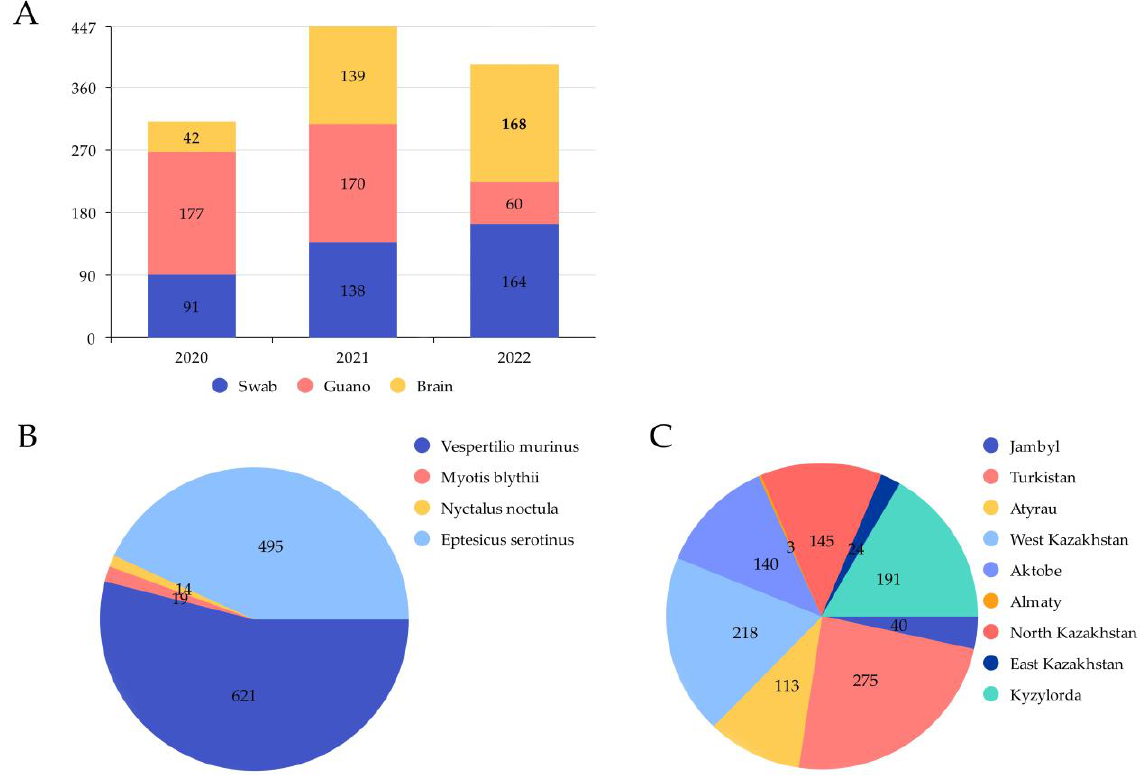
Figure 2. Characterization of the collected samples. ( A ) Graph showing the distribution of the number of samples taken from 2020 to 2022. ( B ) Number of samples taken by region. ( C ) Number of samples taken from different species of bats.